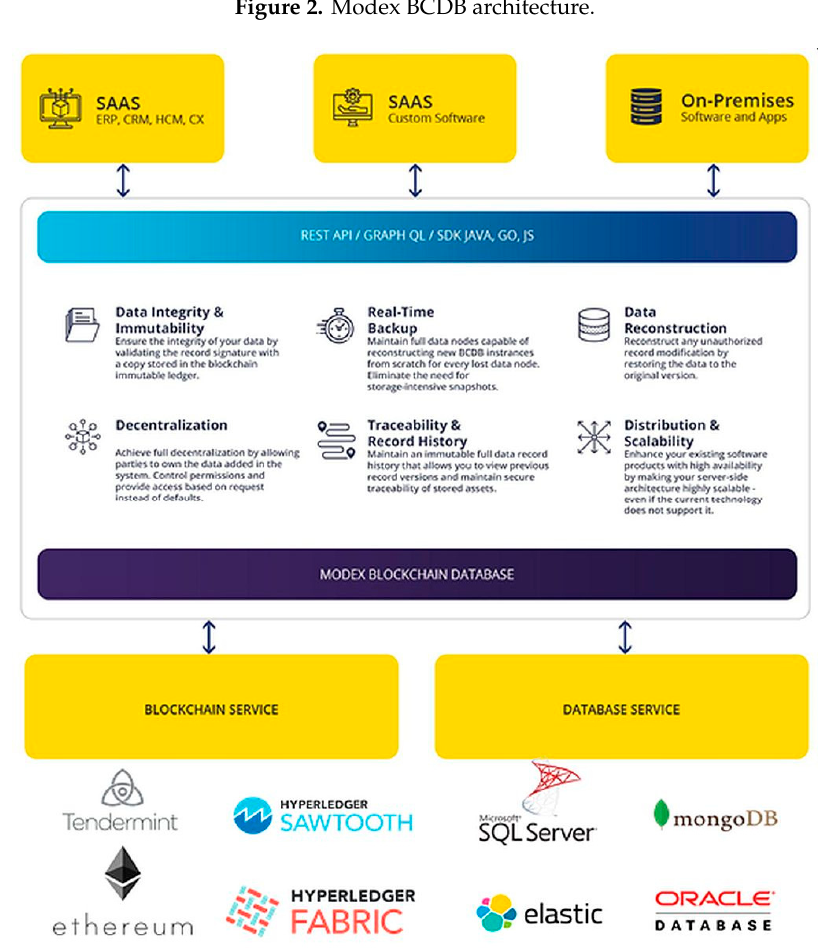
Figure 3. Modex Blockchain Database (BCDB) infrastructure [62]. Reproduced with permission from Modex Ltd . ; published on the www.modex.tech website, 2020.